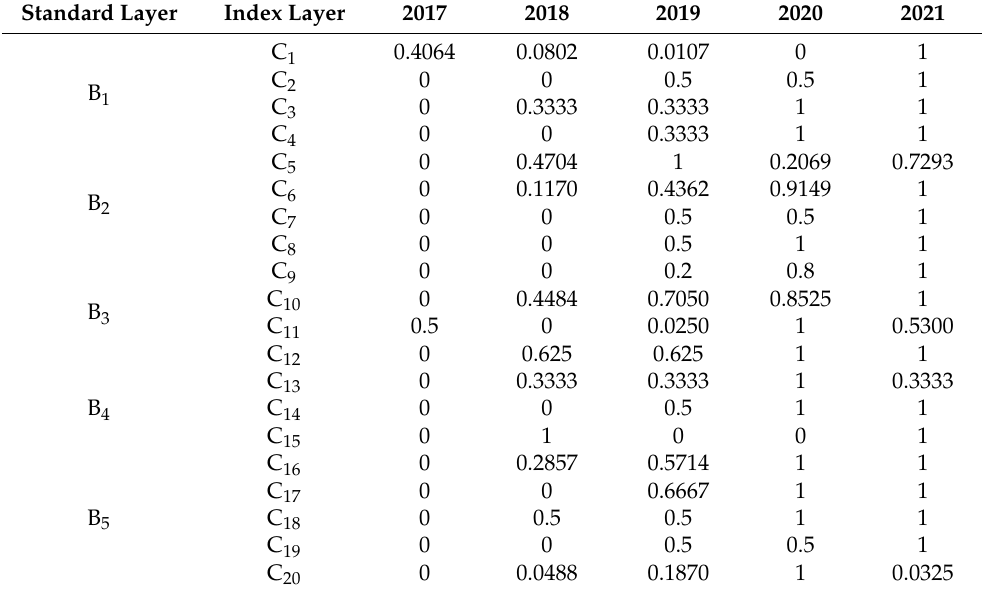
Table 4. Normalized data of each